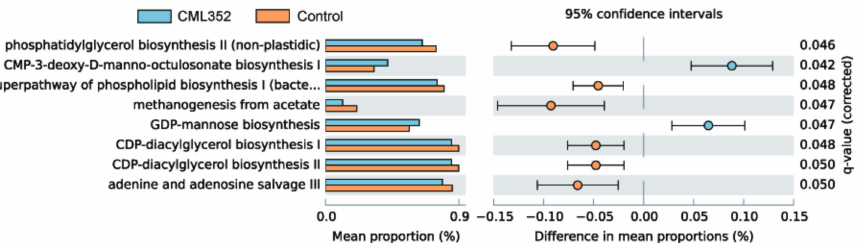
Figure 3. PICRUSt analysis in the MetaCyc pathways; functional predictions for the fecal microbiome of the L. salivarius CML352 group and the control group. Significant MetaCyc pathways for the fecal microbiome of the 2 groups were identified by STAMP software.